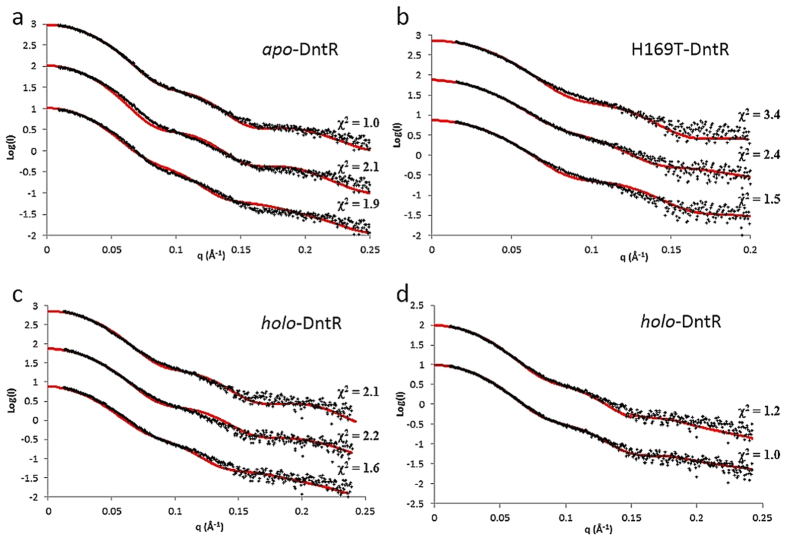
Comparison of the experimental scattering curves of apo-, H169T- and
holo-DntR with theoretical scattering curves based on various
structural models.CRYSOL fits of: (a) The solution scattering curve of apo-DntR
with theoretical curves based on (top) the solution conformation of
apo-DntR shown in Fig. 5a; (middle) the
crystal structure of apo-DntR shown in Fig. 2a
and (bottom) a homology model of an extended, TsaR-type apo-DntR
homotetramer; (b) the solution scattering curve of H169T-DntR with
the same theoretical curves shown in (a); (c) the solution
scattering curve of holo-DntR with the same theoretical scattering
curves shown in (a); (d) the scattering curve of
holo-DntR and theoretical curves based on the SASREF-obtained models
of solution structures of holo-DntR with a central tetrameric core
comprising open (top) or closed (bottom) RDs.